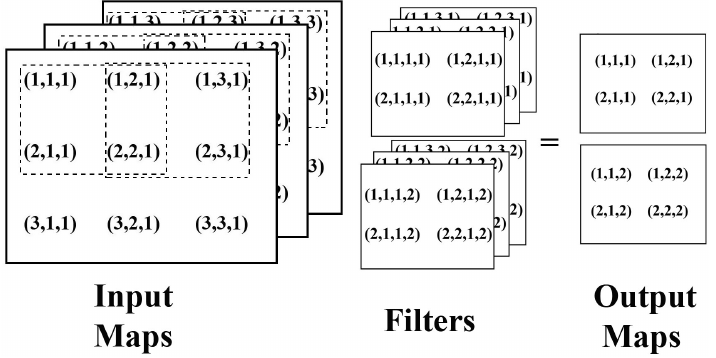
Figure 2. Three-dimensional convolution